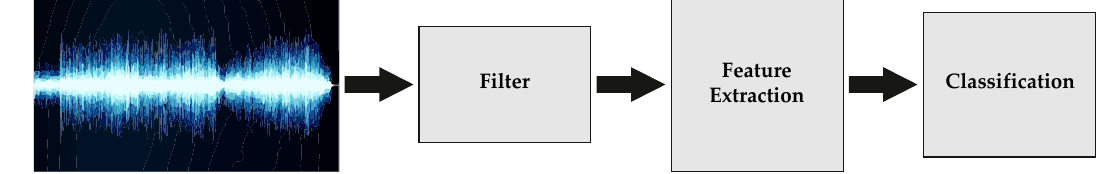
Figure 5. Different phases for the treatment of electromyography (EMG) signals. Figure 5. Di ff erent phases for the treatment of electromyography (EMG)